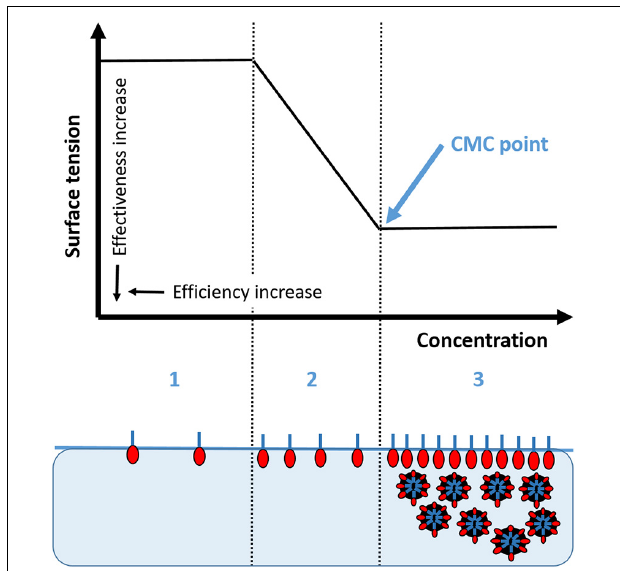
FIGURE 2 | Surface tension as a function of surfactant concentration (logarithmic scale) in three separate phases. (1) low concentration of surfactant, with the round hydrophilic end of the molecule in the water and the long carbon chain or tail interacting with a hydrophobic substance, i.e., air or oil; (2) as the surfactant concentration increases, the interfacial surface tension decreases between the hydrophobic and hydrophilic moieties; and (3) when the concentration of surfactant increases to the critical micelle concentration (CMC) an emulsion is formed where the oil is entrained in the biosurfactant and can be dispersed or form networks or